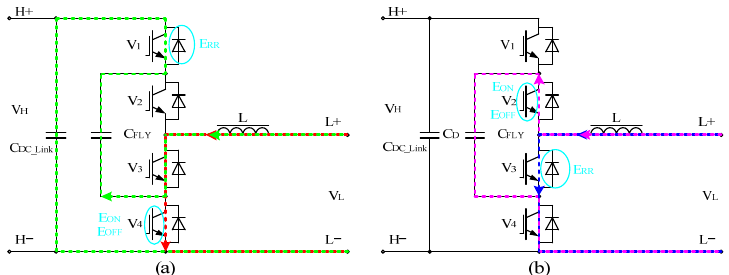
Figure 5. Commutation paths of FC ‐ 3L ‐ BDC. ( a ) Boost mode, D < 0.5 (V 4 switching). ( b ) Boost mode, D < 0.5 (V 3 switching).